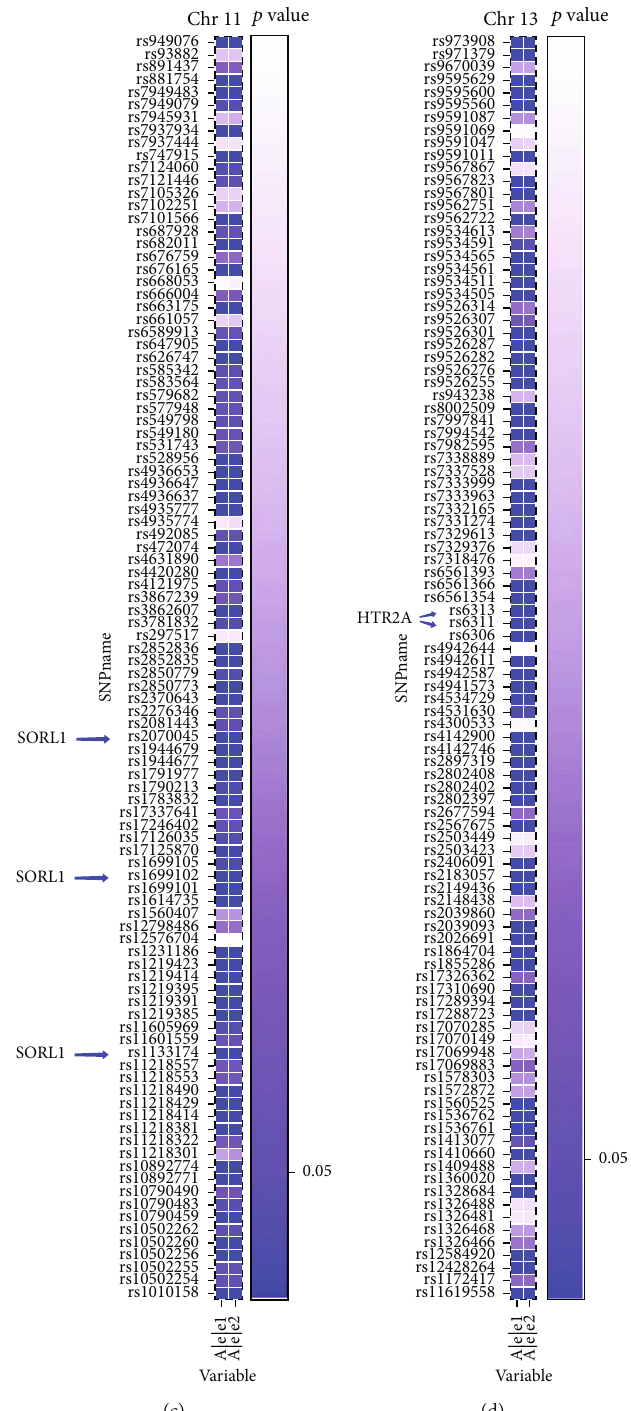
Figure 5: Visualization for part of shared signi fi cant SNPs in AD multitasking classi fi cation at p threshold of 0.05. Rs11136000 (CLU) on chromosome 8 (a); rs543293, rs10501602, and rs3851179 (PICALM) on chromosome 11 (b); rs2070045, rs1699102, and rs1133174 (SORL1) on chromosome 11 (c); and rs6311 and rs6313 (HTR2A) on chromosome 13 (d) are shown successively from left to